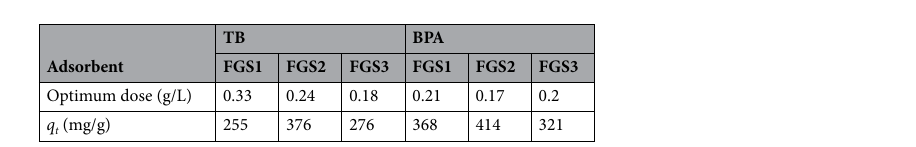
Table 2. The optimum adsorbent dose and q t after 30 min for FGS1, FGS2, and